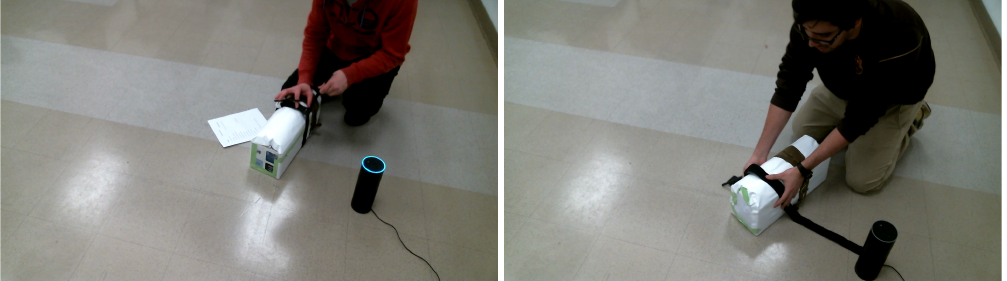
Figure 6. Experimental setup: Participants treating model patient leg with massive hemorrhage (reproduced from